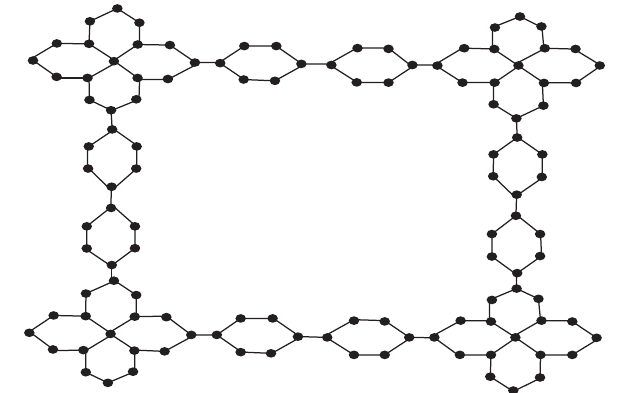
Figure 1: Zinc oxide network ( ZNOX ( n ) � H ) for n �